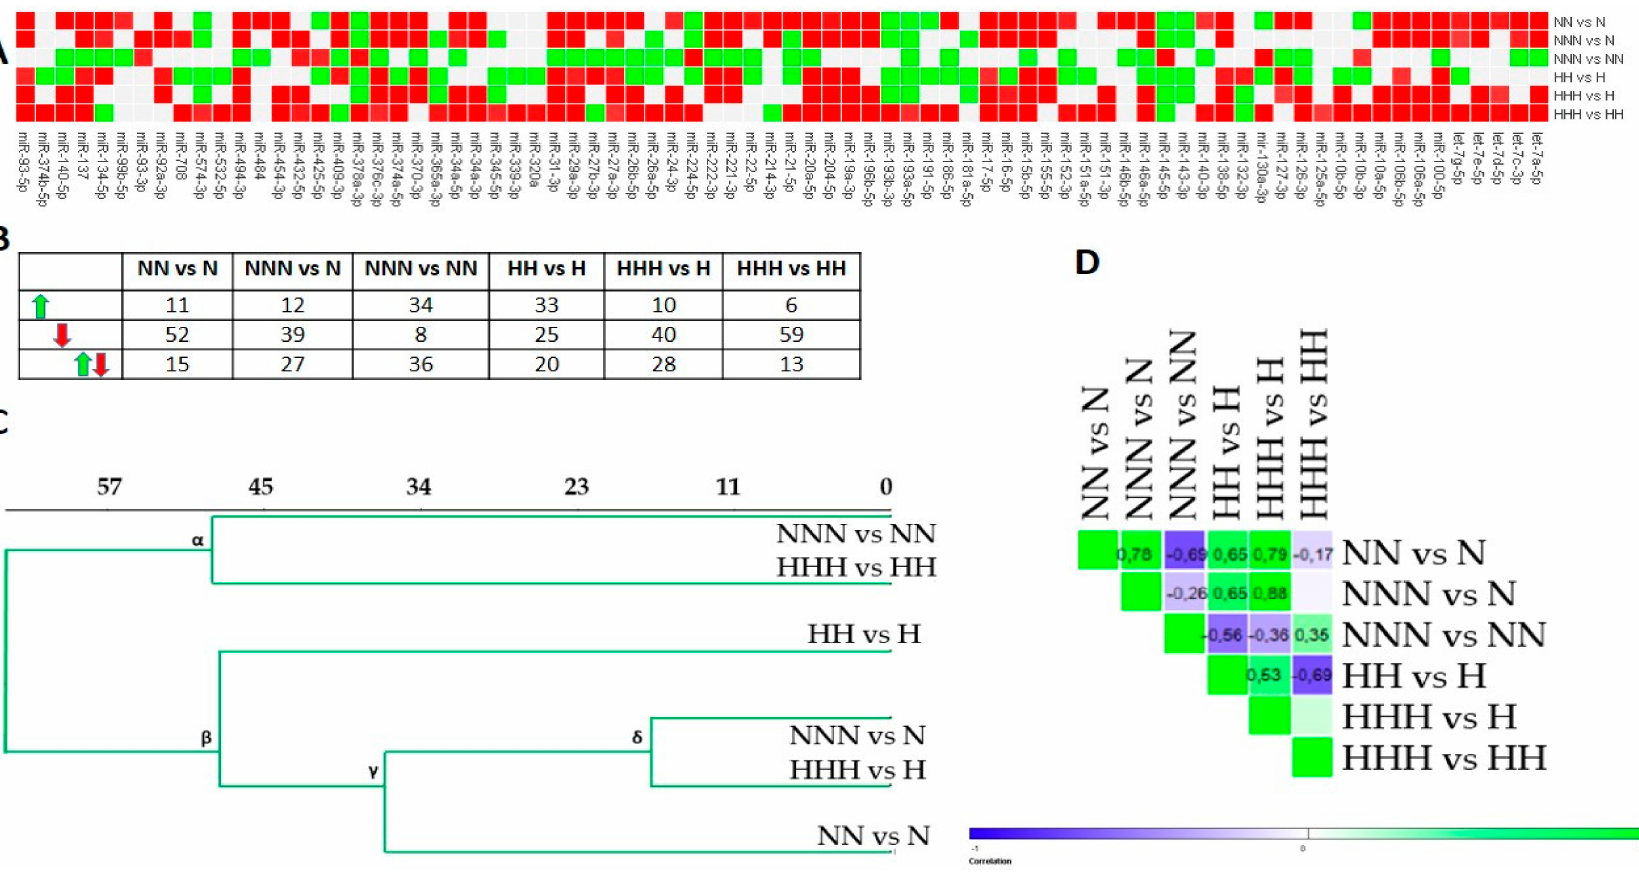
Figure 2. The changes of microRNAs (miRNAs)’ expression in differentiated Ads and mature Ads cultured in NG and HG during adipogenesis (ADG), based on FC (fold change) values. ( A ) The heat map diagram expression changes of examined miRNAs in differentiated adipocytes (Ads) (NN vs. N, HH vs. H), mature Ads in relation to pre-adipocytes (pAds) (NNN vs. N, HHH vs. H) and differentiated Ads (NNN vs. NN, HHH vs. HH). Red denotes expression decline (FC < − 1.5), green indicates expression increase (FC >1.5) and grey shows no changes. ( B ) Table depicts the numerical summary of miRNAs changes from the heat map in ( A ). ( C ) Euclidean hierarchical clustering of miRNAs expression profiles. ( D ) Heat map shows positive (green) and negative (blue) Pearson’s correlation coefficients for comparisons of variants differentiated in NG and